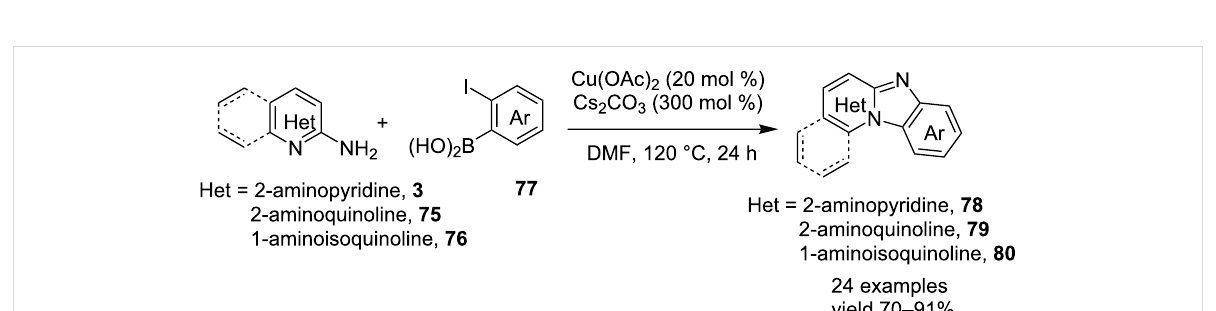
Scheme 26: CuO NPS-promoted A 3 coupling reaction.